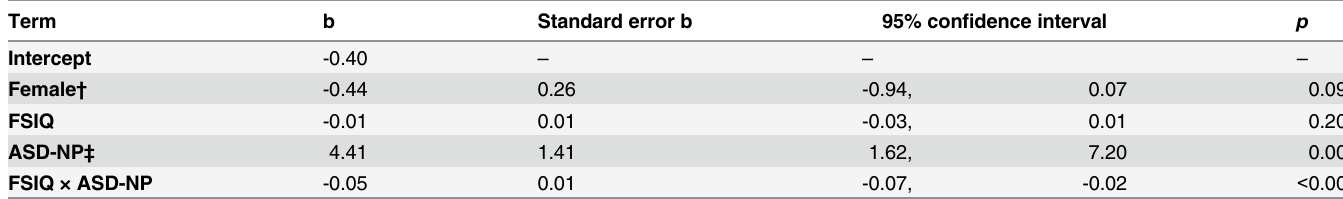
Table 2. Regression model fit to empathizing bias (EB), across both groups (N = 130, given the missing values on FSIQ – see Table